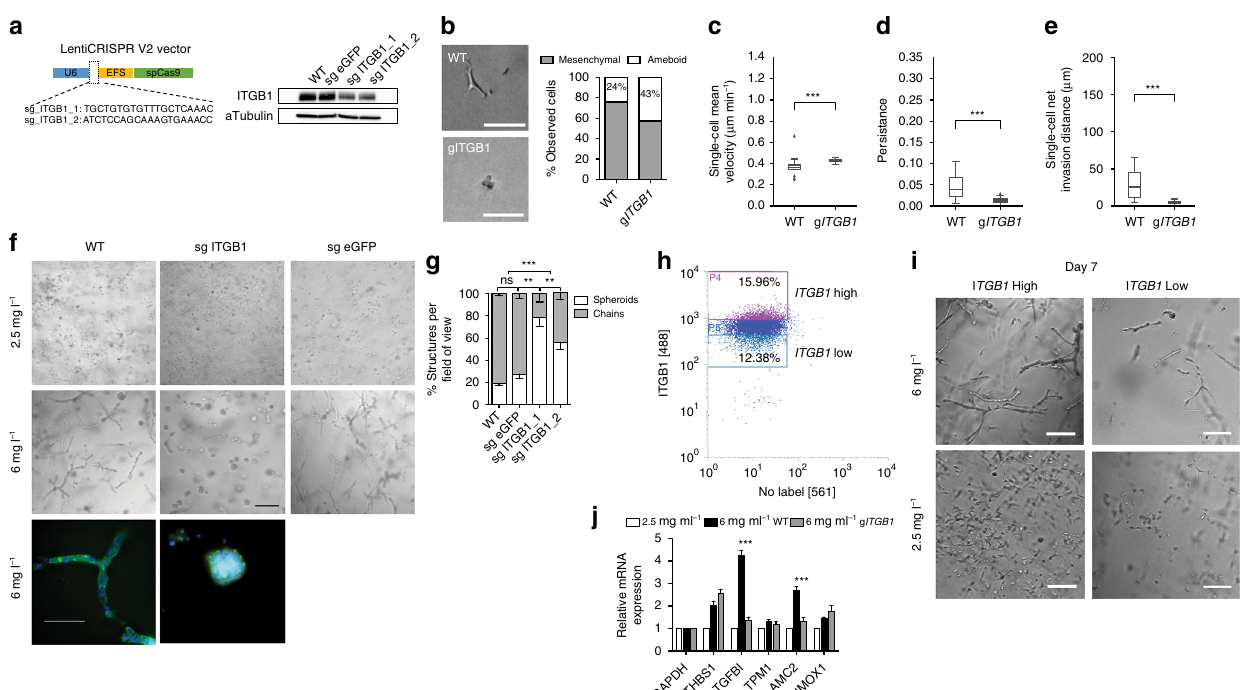
Fig. 4 Role of β 1 integrin in the formation of cell network structures in high-density collagen. a Schematic of lentiCRISPR V2 vector used for targeting ITGB1 gene and western blot validation of the protein depletion after 7 days of cell transduction. b Comparison of MDA-MB-231 cells WT and ITGB1 depleted in low-density 3D collagen. Left: micrographs showing a representative image of a WT cell undergoing mesenchymal migration and an ITGB1 -depleted cell undergoing ameboid migration. Right: quanti fi cation of mesenchymal vs. ameboid migration within the cell populations. c Quanti fi cation of the effect of ITGB1 depletion on mean cell velocity when cells are cultured in 6 mg ml − 1 collagen. d Cell persistence and e cell invasion distance. Comparison for c – e was performed using Mann – Whitney U test. f MDA-MB-231 WT, ITGB1- depleted, and control sgRNA cell phenotypes after 7 days of culture in low- density collagen (top row) and high-density collagen (middle row). Scale bar 250 μ m. Bottom row shows high-magni fi cation micrographs highlighting the difference between chain structures and spheroids. Scale bar 100 μ m. g Quanti fi cation of proportional number of structures in each cell line when cultured in high-density collagen. h Fluorescence-activated cells sorting (FACS) was used to separate the parental WT MD-MB-231 cell line population into high- ITGB1 and low- ITGB1 expressing populations. i ITGB1 high and ITGB1 low cells after 7 days of culture in high-density 3D collagen (top row) and low-density (bottom row). Scale bar 200 μ m. j RT-qPCR quanti fi cation of a small subset of genes identi fi ed in the 70-gene module in WT control- and ITGB1 -silenced cells when cultured in low-density and high-density collagen. Data show mRNA levels relative to GAPDH and relative to low-density collagen level. Statistical signi fi cance evaluated between WT and g ITGB1 groups, Statistical signi fi cance was determined by ANOVA test. Bar graphs represent mean ± s. d. and data in box and whiskers plots is presented using Tukey method. n = 3 biological replicates for all experiments unless otherwise noted. Signi fi cance is indicated as *, **, *** for p ≤ 0.05, p ≤ 0.01, p ≤ 0.001,